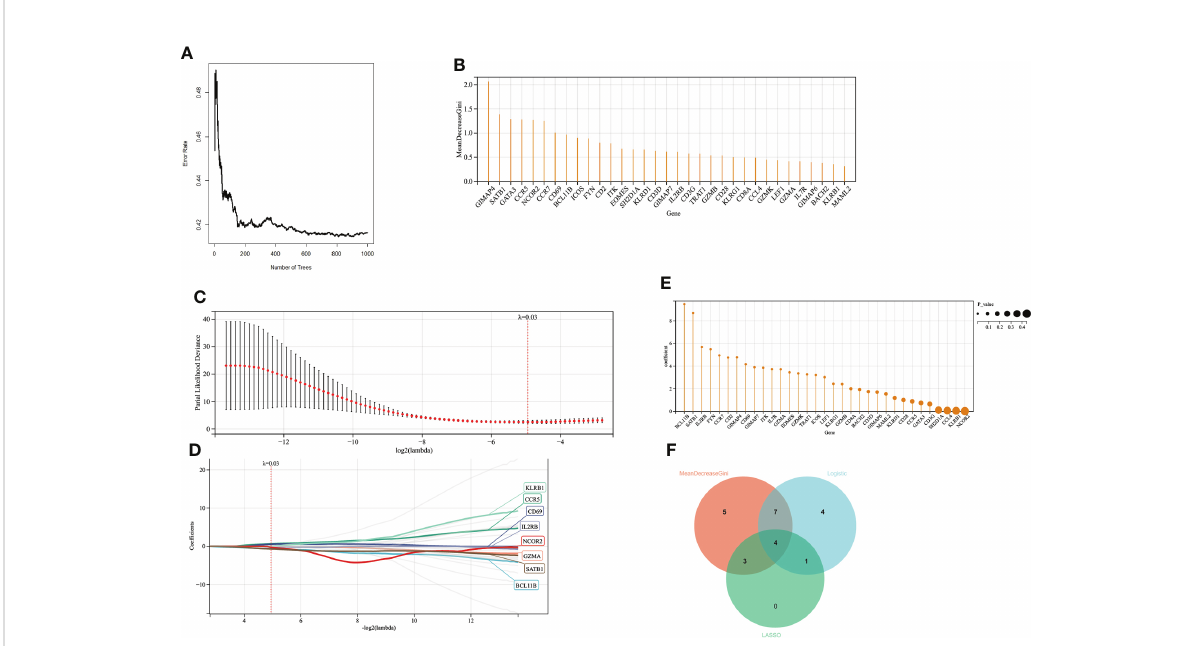
FIGURE 6 Screening variables by machine learning (A) When the random forest selects different numbers of decision trees, the error rate of the classi fi cation results. When the decision tree is 500, it has a lower error rate. (B) The ordinate is the Gini value, representing the variable ’ s importance in the random forest analysis. (C, D) . LASSO regression results have a better screening effect when the coef fi cient is set at 0.03. (E) The results of univariate logistic analysis. The ordinate is the regression coef fi cient, and the size of the circle is proportional to the P value. (F) Intersection of random forest, lasso regression, and univariate logistic regression results.